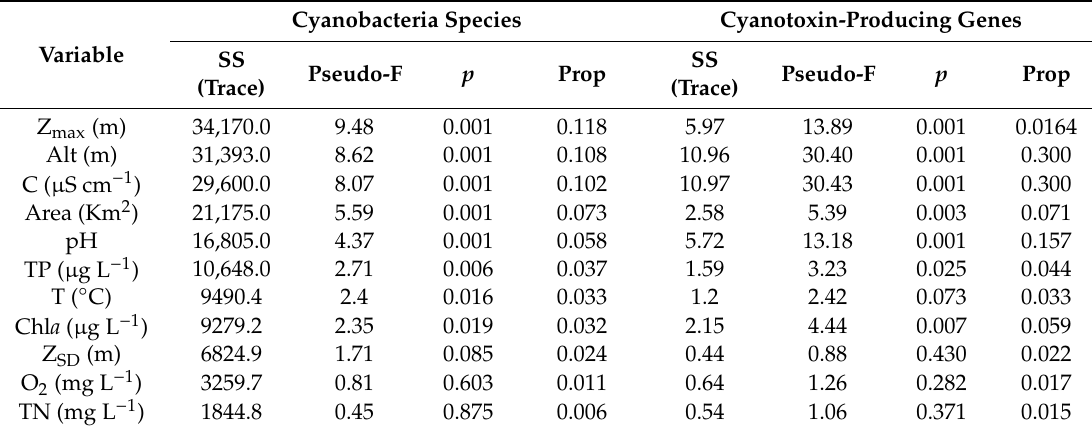
Table 2. Summary of Distance-based linear modeling (DistLM) procedure for environmental variables for cyanobacteria diversity and cyanotoxin producing genes amplification.